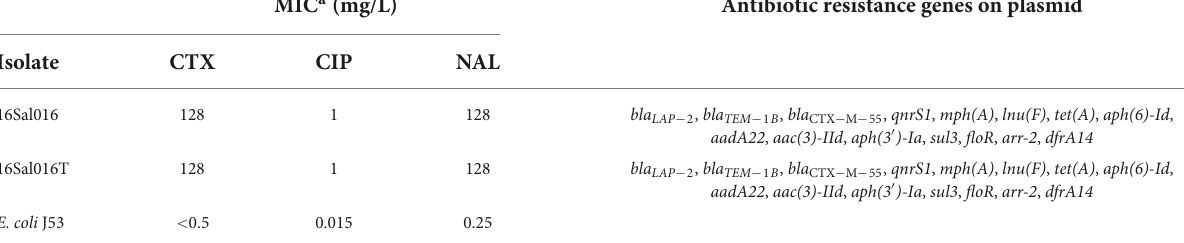
TABLE 1 The antibiotic resistance profile and drug resistance genes of S . Saintpaul 16Sal016, the selected transformant (16Sal016T), and the recipient ( E. coli J53). MIC a